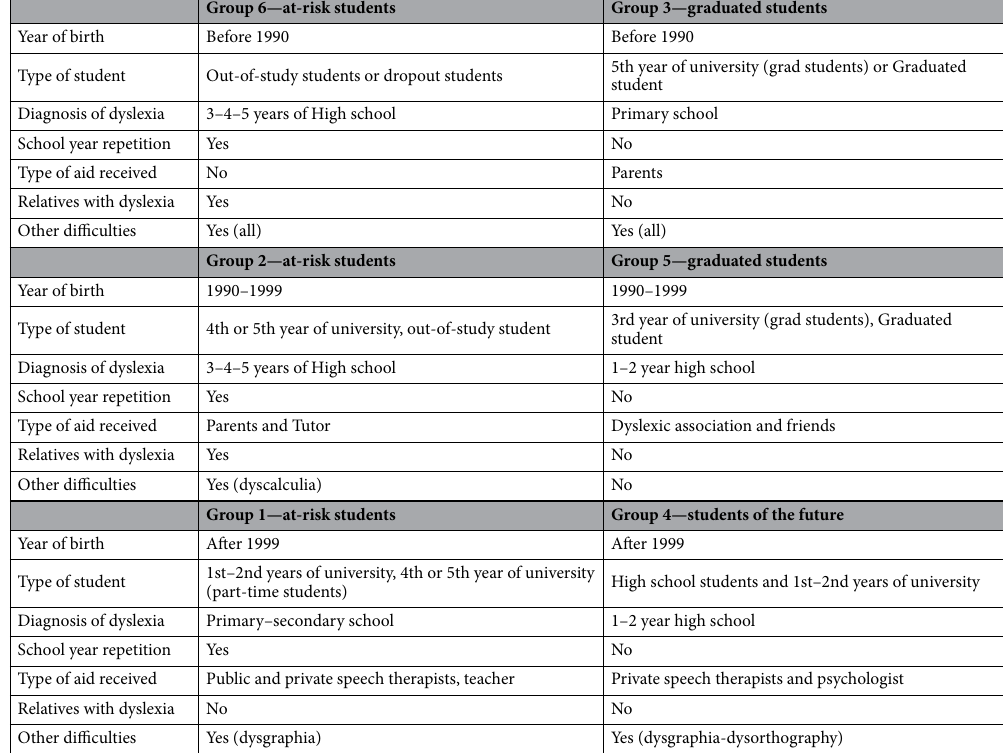
Table 2. Groups identification by considering socio-demographic characteristics.